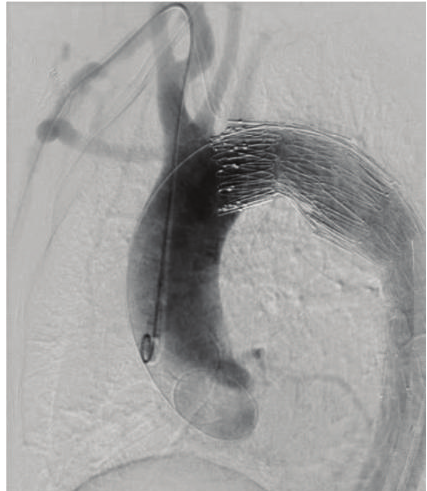
Figure 3: An aortography image (LAO 45) showing the disappearance of the connection between the TAA and the pulmonary artery after stent graft